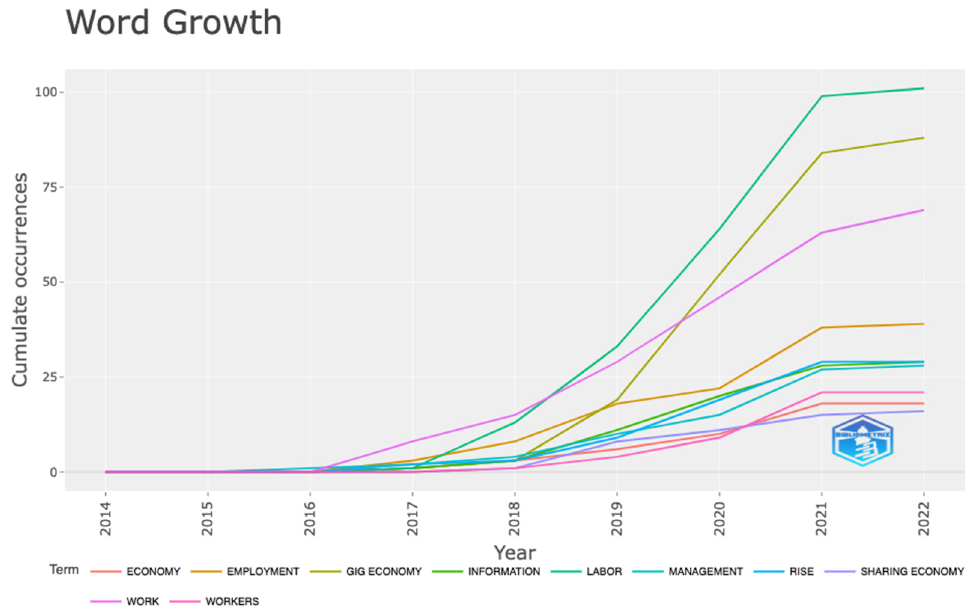
Figure 8. Keywords dendrogram using a hierarchical clustering method. Source: R studio results.